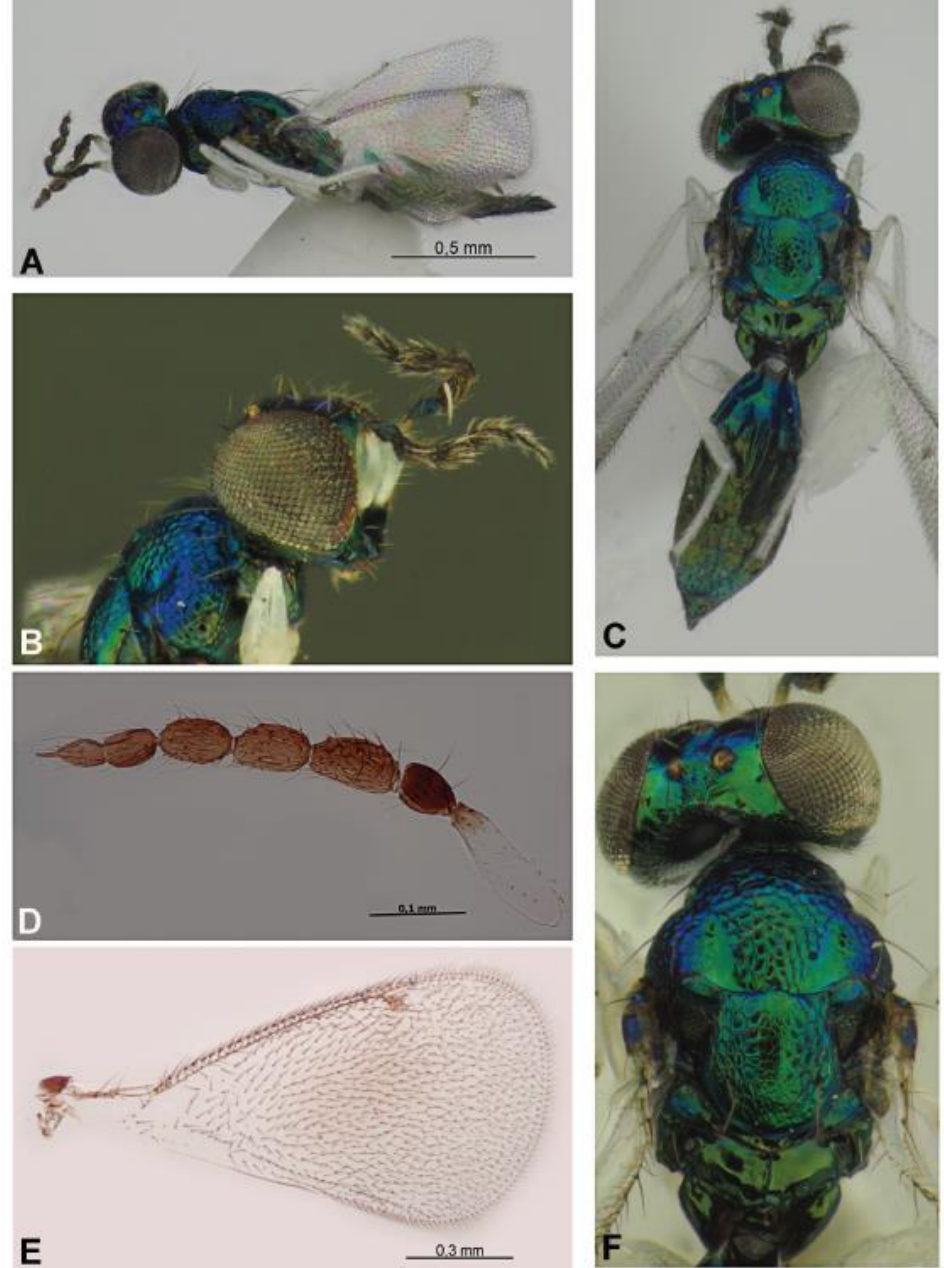
Figure 9. Entedoninae: Achrysocharoides carinatus sp. nov. (female), holotype ( A – E ) and paratype ( F ). Habitus in lateral view ( A ) and dorsal view ( C ), head with antenna in lateral view ( B ), antenna ( D ), fore wing ( E ), head and mesosoma in dorsal view ( F ). Material examined. Holotype: female, Primorskiy Territory, Ussuriysk District, Gor- Mesosoma 1.4 times as long as broad (Figure 9C). Mesoscutum 1.67 times as broad notaezhnoe, forested area around village, from Ph. issikii mine on Tilia mandshurica , 8.VII.2021 (leaf mine coll.), 9 –28.VII.2021, N. Kirichenko coll.”, RFE -PD No. 7. Paratype. One female with the same label as in holotype. Description. Female. Length 1.6 mm.